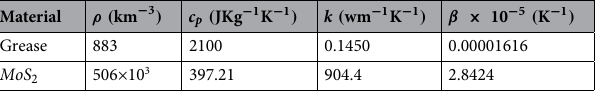
Table 1. Thermophysical properties of grease and MoS 2 44–49 :